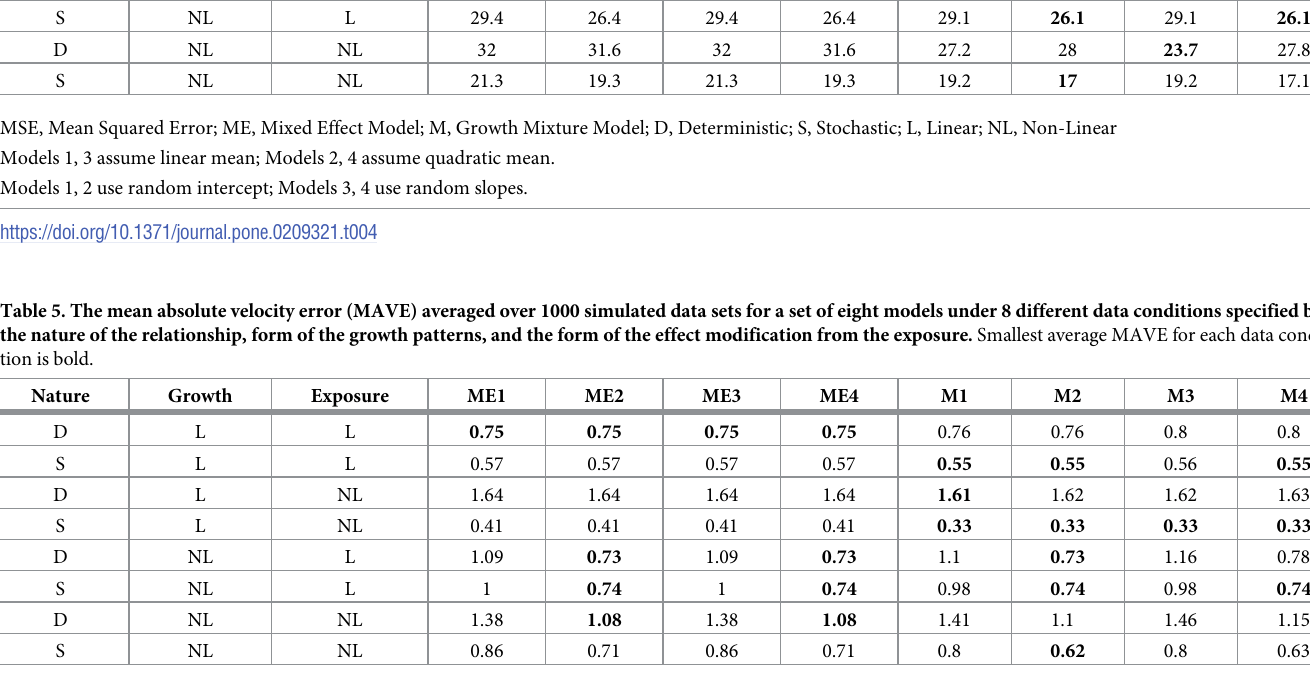
ME, Mixed Effect Model; M, Growth Mixture Model; D, Deterministic; S, Stochastic; L, Linear; NL, Non-Linear Models 1, 3 assume linear mean; Models 2, 4 assume quadratic mean. Models 1, 2 use random intercept; Models 3, 4 use random